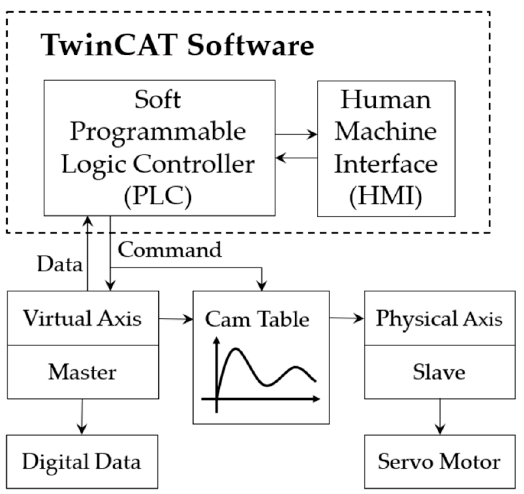
Figure 8. The structure of the compensation system.